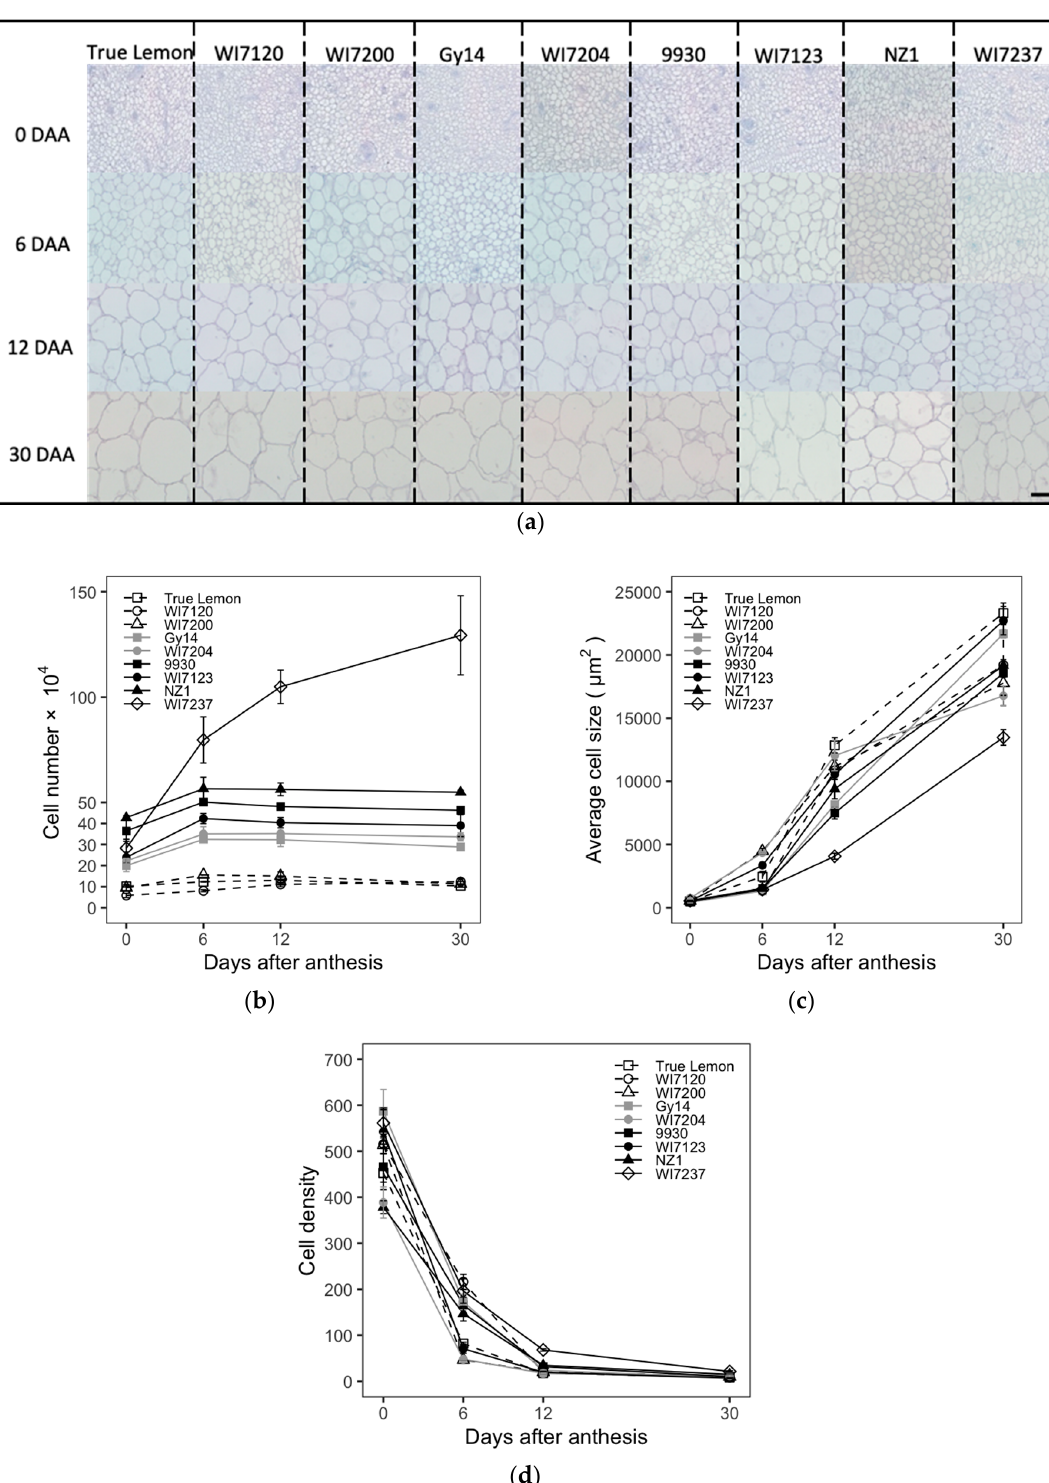
Figure 2. The dynamic cellular changes of fruit cells in the longitudinal sections among nine cucumber inbred lines. ( a ) The represented ovary and fruit cell pictures of different development stages. ( b ) Cell number. ( c ) Average cell size. ( d ) Cell density. Each value is the mean ± SE of 3 fruits. Bar = 100 μ m . The phenotypic data of fruit cell number, size, and density at the ovary (0 DAA) and mature fruit (30 DAA) stages collected from those nine cucumber varieties are listed in the Table 2. Among these nine cucumber cultivars, the extremely long cucumber WI7237 had the most abundant fruit cell number in the longitudinal section and the highest fruit cell density in both cross and longitudinal sections; however, the fruit cell size of WI7237 was the smallest in both vertical and horizontal sections; the cucumber landrace True Lemon showed the smallest and largest fruit cell number and cell size in the longitudinal section, respectively; the North China fresh market type cucumber WI7123 had the lowest fruit cell density in the longitudinal section and the smallest fruit cell number in the cross-section, while the largest fruit cell number in the cross-section was shown in the US pickling cucumber Gy14; in addition, the Beit Alpha cucumber WI7204 showed the largest fruit cell size and the lowest cell density in the cross-section, respectively (Table 2). Overall, the cucumber varieties with different fruit sizes and shapes had different cell number, size, and density in both longitudinal section and cross-section of cucumber fruits, which indicated that the complex process of cucumber fruit size and shape determination in the cellular levels. Nevertheless, the fruit cell number, size, and density should be three primary factors in the final form of cucumber fruit size and shape. Table 2. Cell number, average cell size and cell density of longitudinal and cross sections for nine cucumbers at anthesis (0 DAA) and mature stage (30 DAA). Longitudinal Section